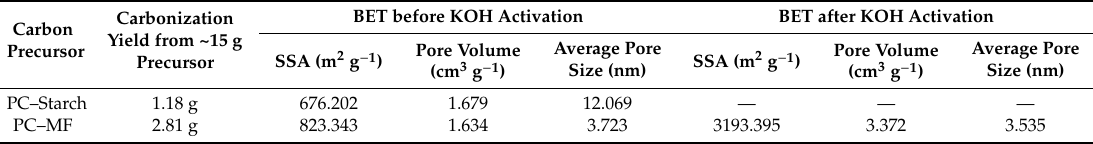
Table 3. BET results of new activated carbon (AC) materials.